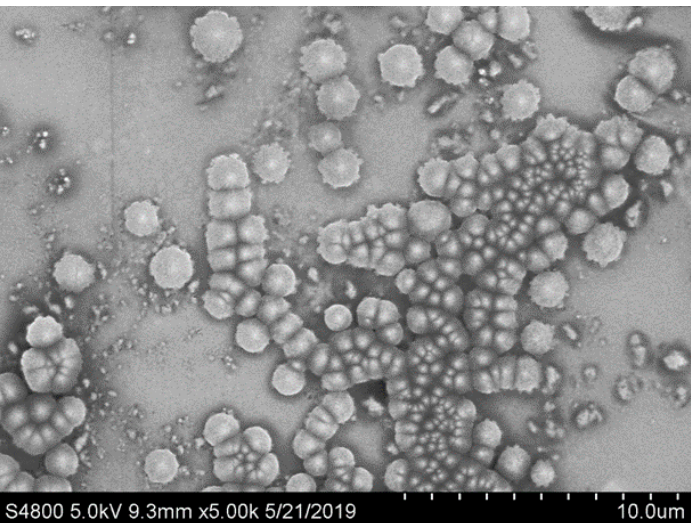
Figure 5. SEM image of cholic conjugated chitosan derivative 1.